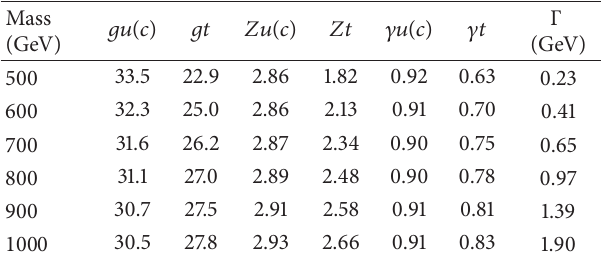
Table 1: Branching ratios (%) and decay width of the new heavy quark ( 𝑡 󸀠 ) with only anomalous interactions for PI parametrization and 𝜅/Λ = 0.1TeV −1